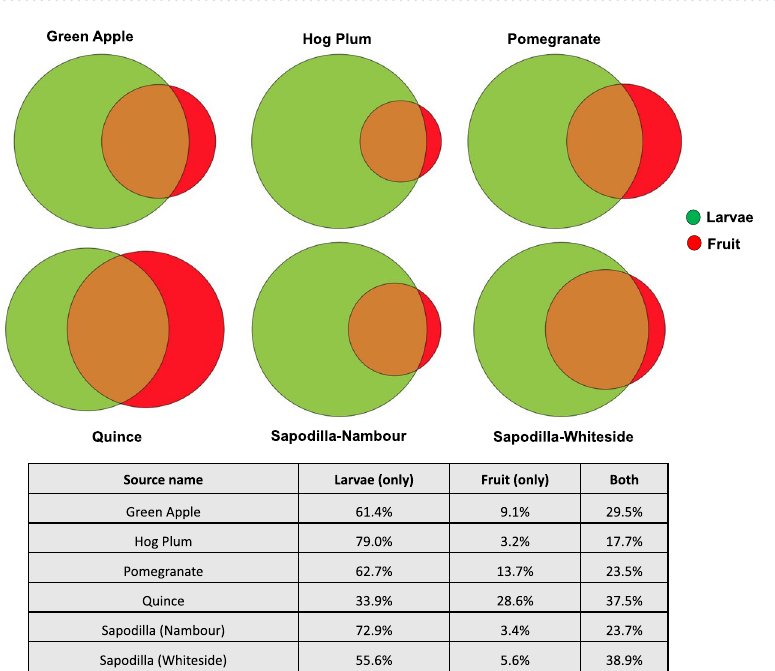
Figure 4. Venn diagram of the percentage of the bacteria present in the larvae only, fruits only and common in both collected from five different types of fruit in the